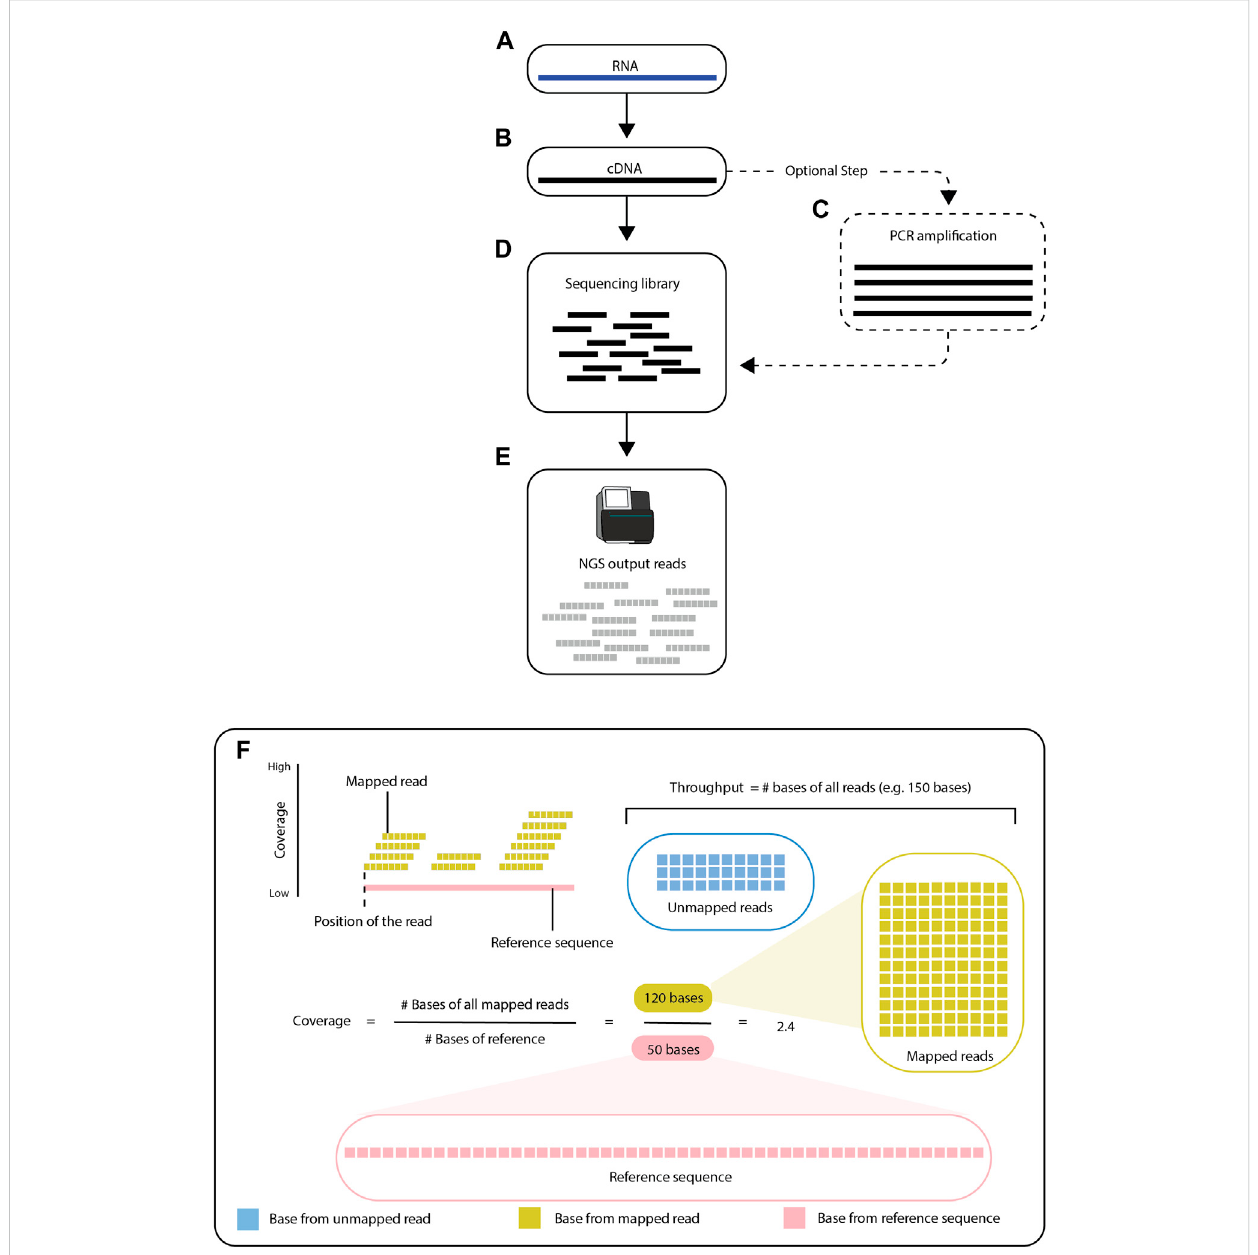
FIGURE 1 Overview of RNA-seq. RNA-seq is a process of creating short sequencing reads from RNA molecules. The steps consist of fi rst converting the RNA (A) into cDNA (B) , then (optionally) amplifying the cDNA by PCR (C) , and fi nally fragmenting the cDNA into short pieces (known as fragments). After the sequencinglibrary (D) isprepared,thefragmentsareused asinputfor next-generation sequencing (E) .TheresultingsequencereadscontainedinFASTQ fi lesare then aligned to a reference sequence (F) . Modern high-throughputsequencing machines can generate up to 150 million reads per run. The reference sequence, shown as a pink line, is known. The goal of the alignment is to fi nd the locus in the reference sequence with the greatest match to each read. Reads are shown to align to the speci fi c positions/locations and these mapped locations are